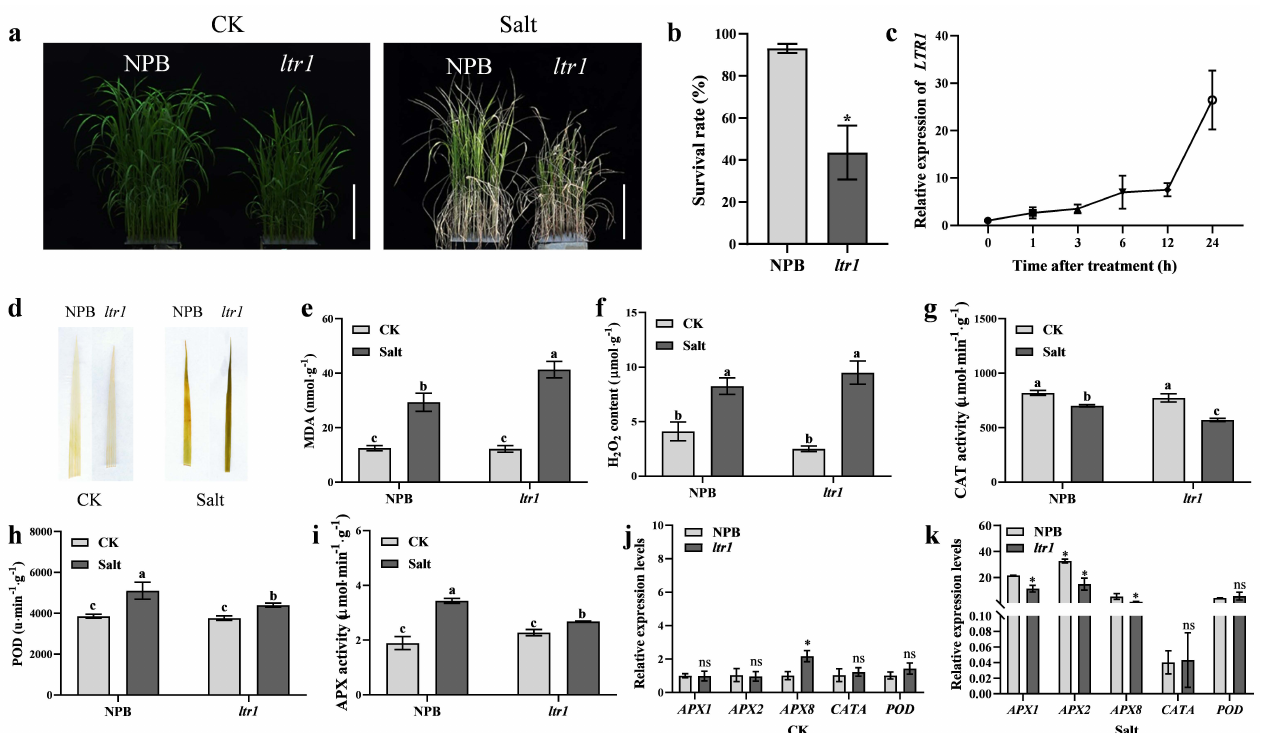
Figure 8. The response of LTR1 to salt stress in NPB and ltr1 . ( a ) Photos of NPB and ltr1 under CK and Salt treatment, bar = 10.5 cm. ( b ) The survival rate of NPB and ltr1 after treatment for 7 d. ( c ) The relative expression level of LTR1 after treatment for 0, 1, 3, 6, 12, 24 h. ( d ) DAB staining in leaves of NPB and ltr1 under CK and salt treatment. ( e , f ) MDA and H 2 O 2 content in leaves of NPB and ltr1 under CK and Salt treatment. ( g – i ) CAT, POD, and APX activity in leaves of NPB and ltr1 under CK and salt treatment. ( j , k ) The relative expression level of genes related to antioxidant system in leaves of NPB and ltr1 under CK and Salt treatment, n = 4. Data are given as means ± SD. Asterisks indicate significant difference based on the Student’s t -test: * in the figure represents significant difference at p < 0.05 and ns in the figure represents there is no significant difference at p < 0.05. Different lowercase letters indicate significant differences based on the Duncan’s new multiple range test ( p <